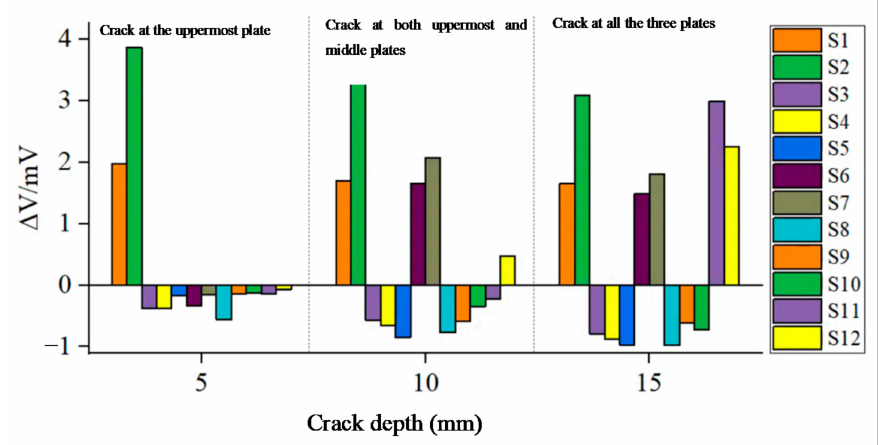
Figure 18. Experimental results as the crack grows in the axial